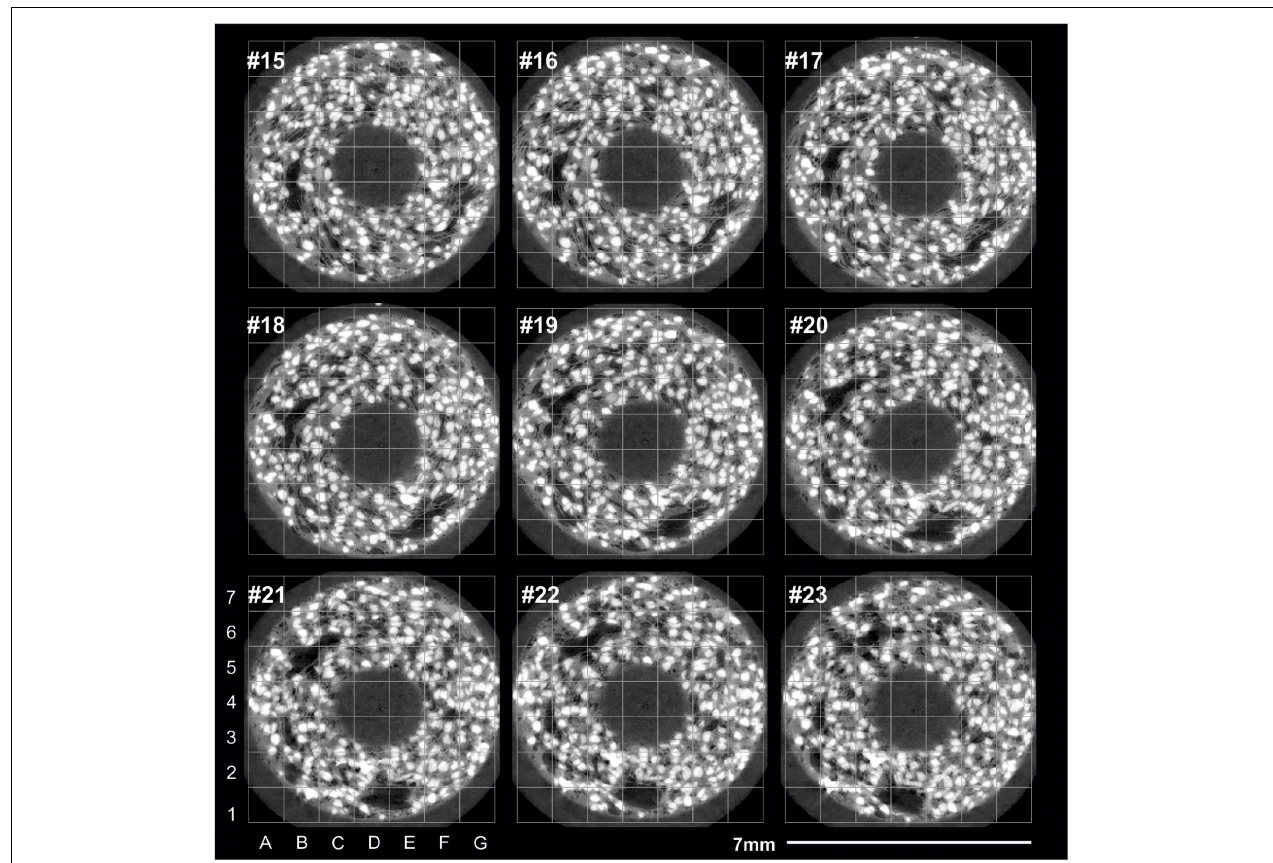
FIGURE 8 | Two-dimensional grayscale slices perpendicular to the rotation axis showing the deformation and coalescence in a selection of slices through a three-phase system. The sample was sintered from the same glass bead pack with 30% rutile crystals. See text for discussion.